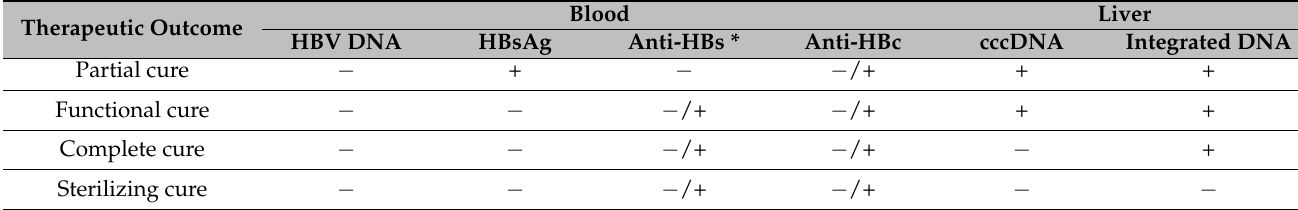
Table 1. Definitions of therapeutic endpoints for HBV therapy. Blood Liver Therapeutic Outcome HBV DNA HBsAg Anti-HBs * Anti-HBc cccDNA Integrated